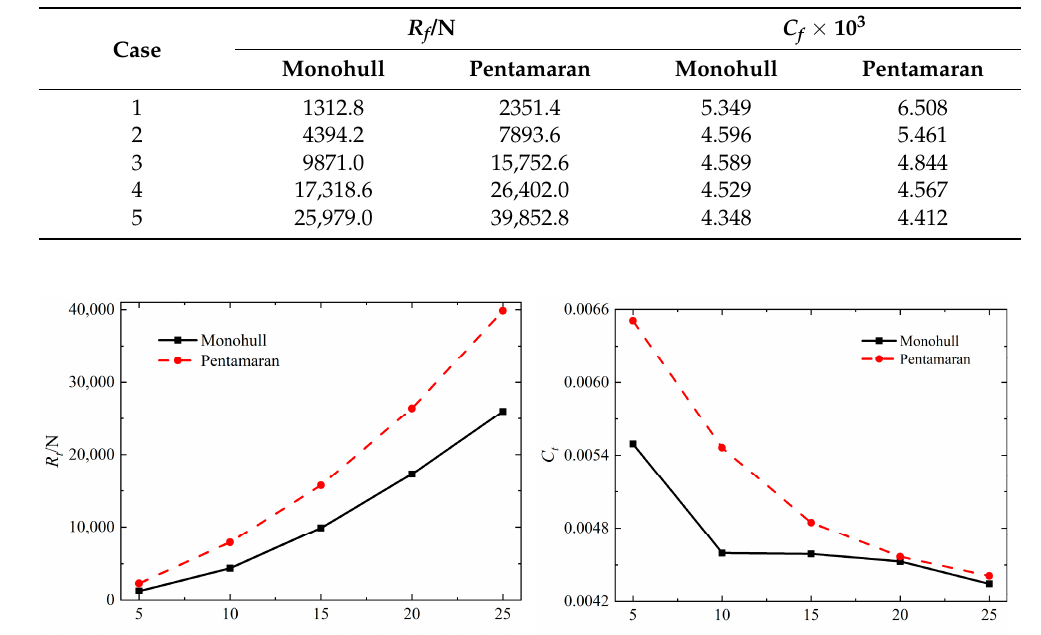
Figure 15. R f and C f curves.